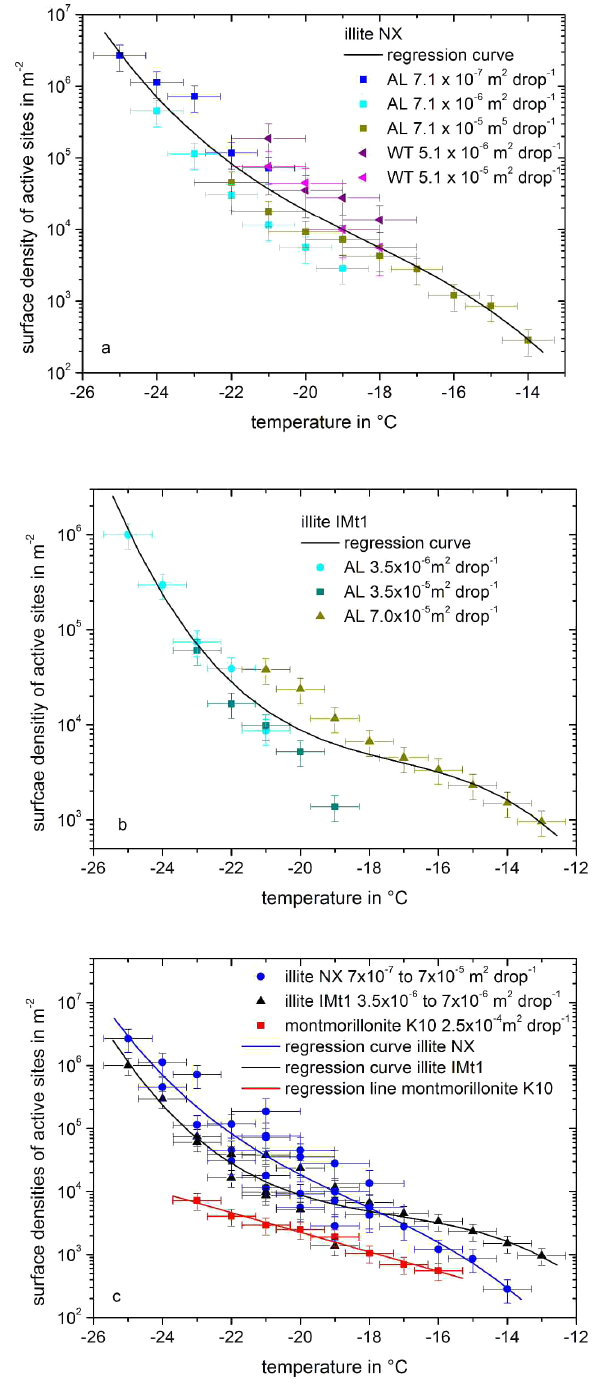
Figure 8. Surface densities of active sites as functions of temper- ature for various particle surface areas per drop. Illite NX, deter- mined by the acoustic levitator (AL) and the wind tunnel (WT) (a) . Illite IMt1, determined by the acoustic levitator (b) . Comparison of montmorillonite K10, illite NX, and illite IMt1 (c) .